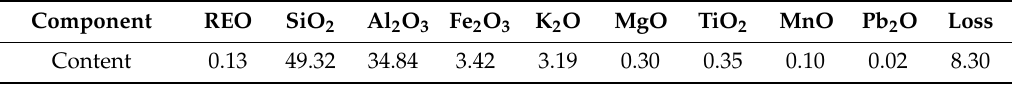
Table 1. Main chemical composition of the ore samples.